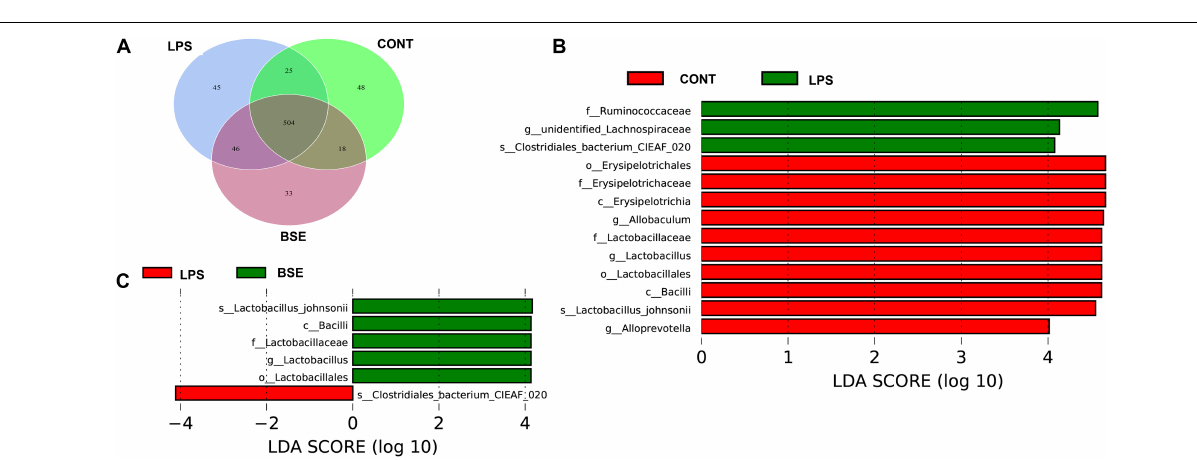
FIGURE 6 | Effects of Blidingia sp. extract on relative abundance of predominant bacteria at the order and family level in cecum of lipopolysaccharide-challenged mice. Relative abundance of predominant bacteria at the class (A,B) , and family (C,D) level. CONT, mice gavaged with sterile saline; LPS, mice injected with lipopolysaccharide; and BSE, mice gavaged with Blidingia sp. extract and injected with lipopolysaccharide. Values are expressed as mean ± SEM, n = 7; ∗ p < 0.05.